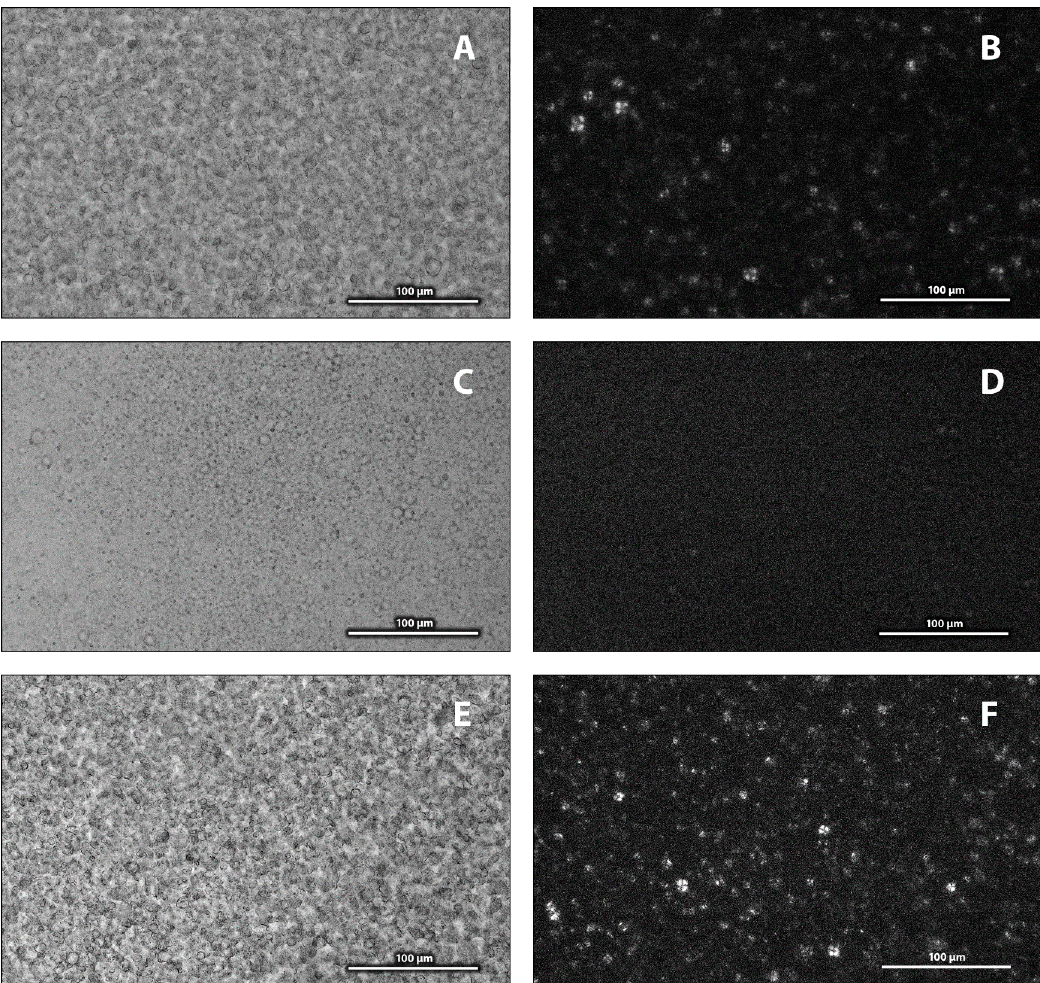
Figure 3. Photographic images recorded in normal and polarised light for aqueous dispersions of modified porcine surfactant (PSUR) ( A , B ), PSUR and 10% lipopolysaccharide (LPS) incubated for 2 h at 37 °C ( C , D ), and PSUR/10% LPS and 3% PxB ( E , F